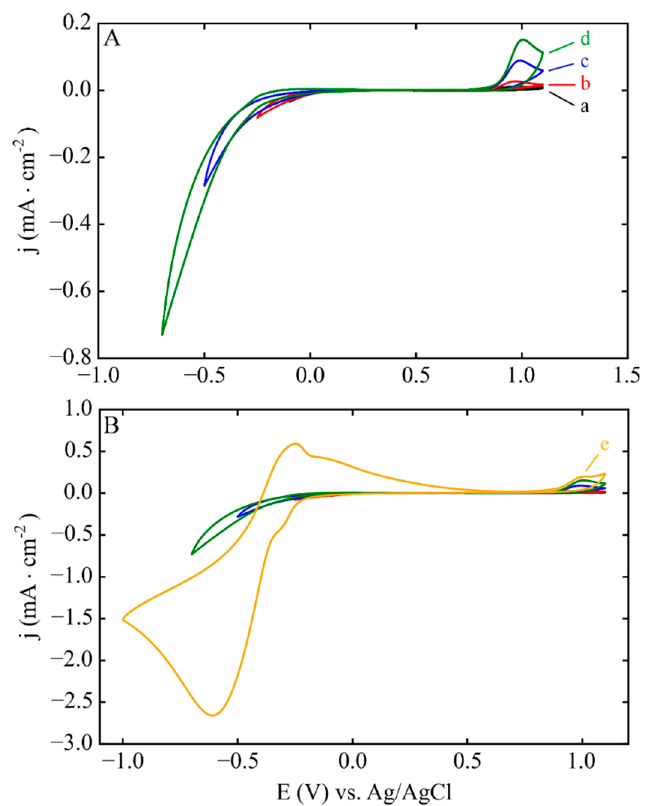
Figure 4. ( A ) Sequence of cyclic voltammograms (CVs) of Pt deposition on the same HOPG surface (a–d), ν = 50 mV/s. The CVs increase the potential window in the negative direction. ( B ) Shows the same CVs in ( A ) for comparison with the final CV (e).